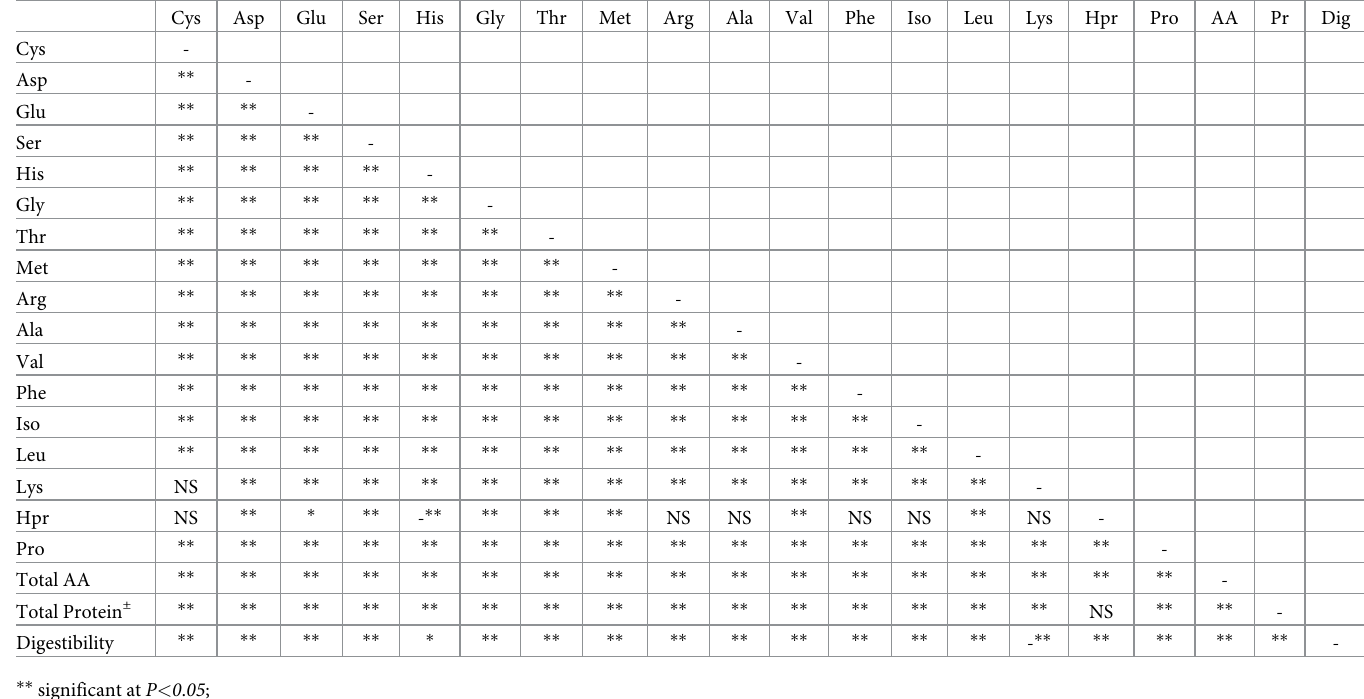
Table 3. Pearson’s correlation analysis of nutritional traits among dry pea cultivars grown in the organic system. Cys Asp